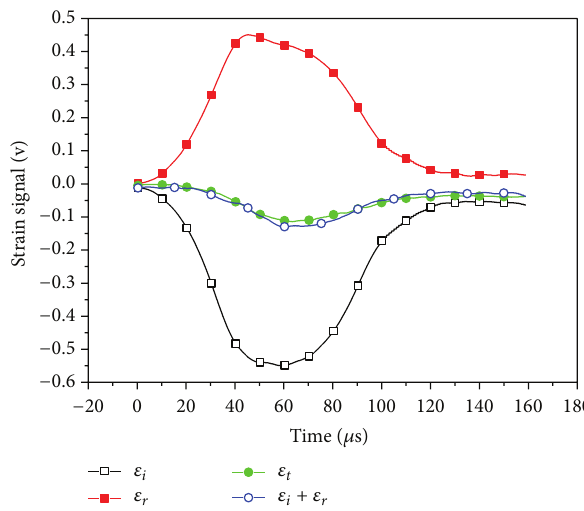
Figure 1: The strain signals in the bars. 𝜀 𝑖 : incident strain, 𝜀 𝑟 : reflect- ed strain, and 𝜀 𝑡 : transmitted